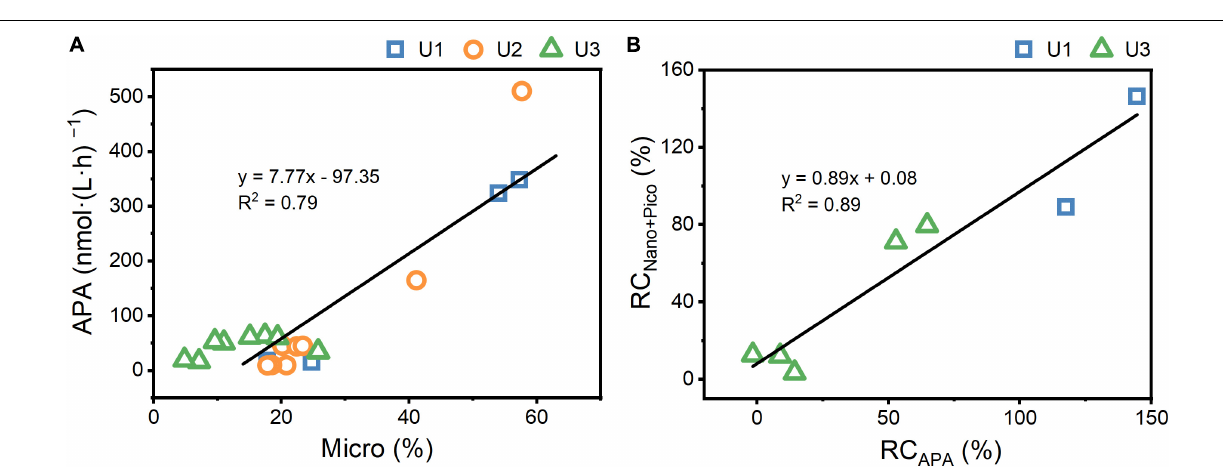
FIGURE 8 | The relationship between APA and the contribution of microsized Chl a to the total Chl a in the AR treatments (A) and the relationship between relative change in APA (RC APA ) and nanosized+picosized Chl a (RC Nano + Pico ) in the unfiltered seawater relative to the filtered seawater (B) . RC APA and RC Nano + Pico was calculated as ([mean in the unfiltered seawater - mean in the filtered seawater]/mean in the filtered seawater) × 100. The contribution of microsized Chl a to the total Chl a in the control was less than 15% throughout the experiments, and thus, there was no incubations with filtered seawater at U2 Sur